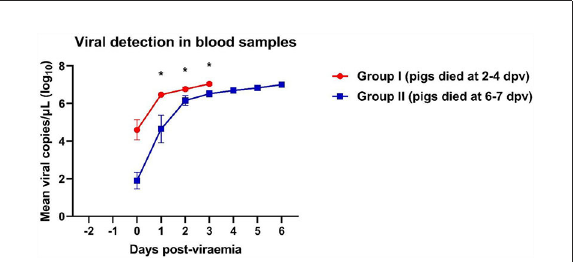
FIGURE1 Viral load in pigs experimentally infected with African swine fever virus. Mean viral copy number per microliter in two groups divided by the number of days between the onset of viremia and death. * p < 0.05. dpv, days post-viremia.